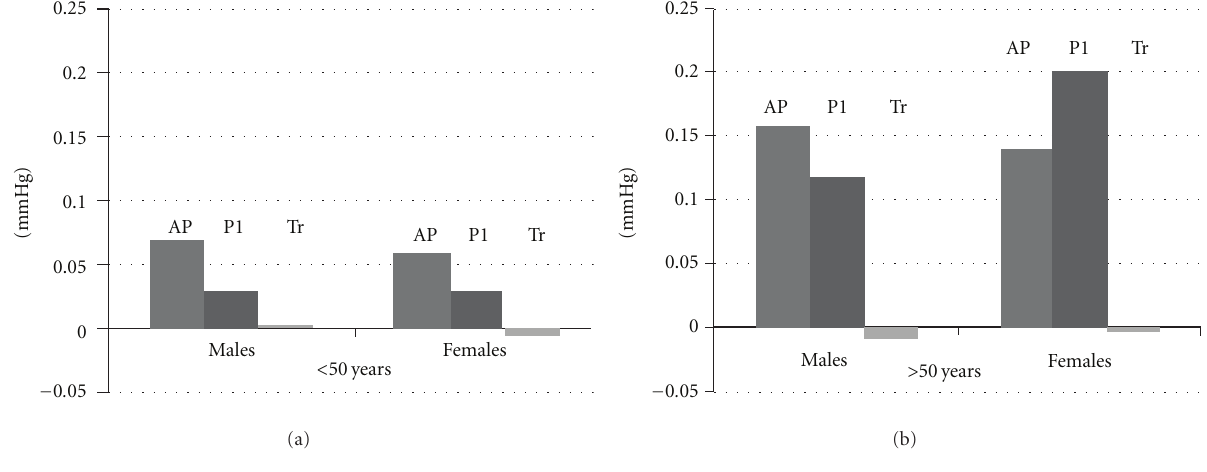
Figure 3: Gender-wise per year contribution of augmented pressure (AP), incident pressure (P1), and round trip travel time (Tr) to the aortic systolic pressure before and after 50